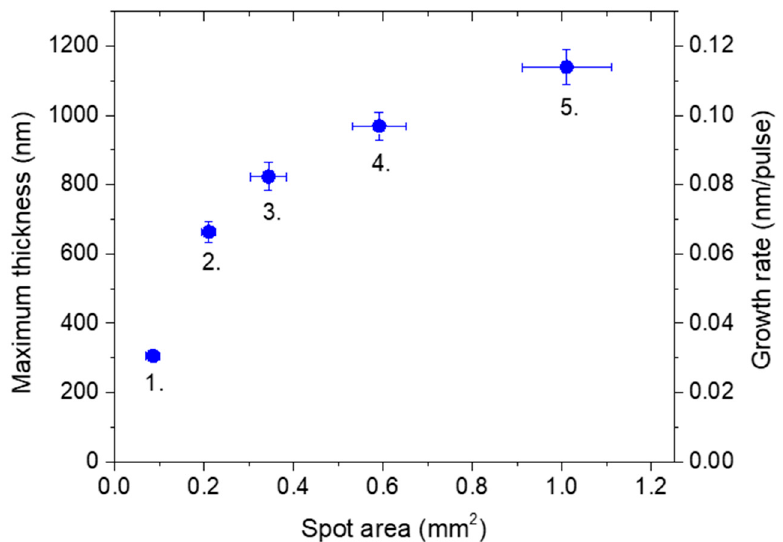
Figure 3. The evolution of maximum thickness and the growth rate derived with rising spot area. The numbers 1.–5. refer to lens positions to facilitate the assignment of the thickness data to the respective process parameters listed in Table 1.